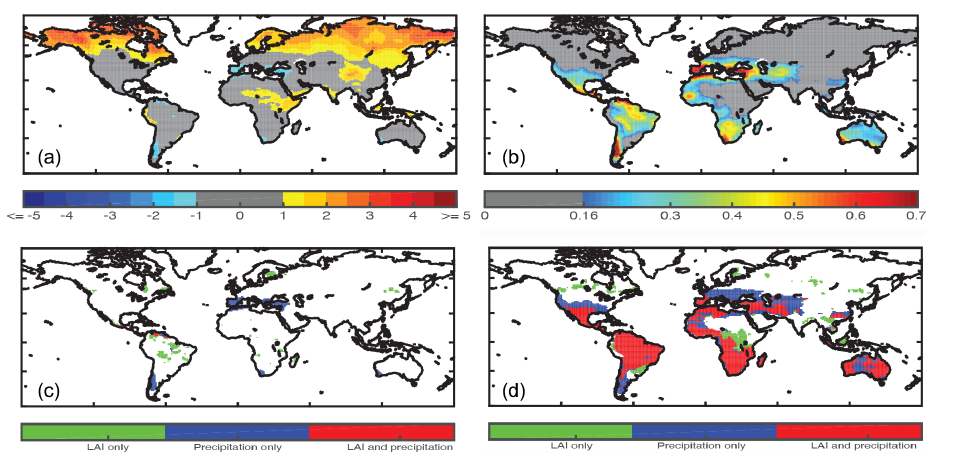
Figure 5. Mean of all models for the change in annual mean precipitation for 2081–2100 compared to current (1981–2000), normalized by the model standard deviation for RCP8.5 (similar to Fig. 2c, but for precipitation) (a) . Mean of the models percent of the time during which the annual mean precipitation is 1standard deviation below current values (similar to (c) , but for precipitation) for 2081–2100 in RCP8.5 (b) . Grid-boxes identified as statistically significantly decreasing in LAI (green) or precipitation (blue) or both (red) (i.e., the blue regions in Figs. 2a and 6a contrasted) (c) . Grid-boxes identified as having an increase in the amount of time with low LAI (green) or precipitation (blue) or both (red) (i.e., the blue regions in Figs. 5c and 6b contrasted) (c) .